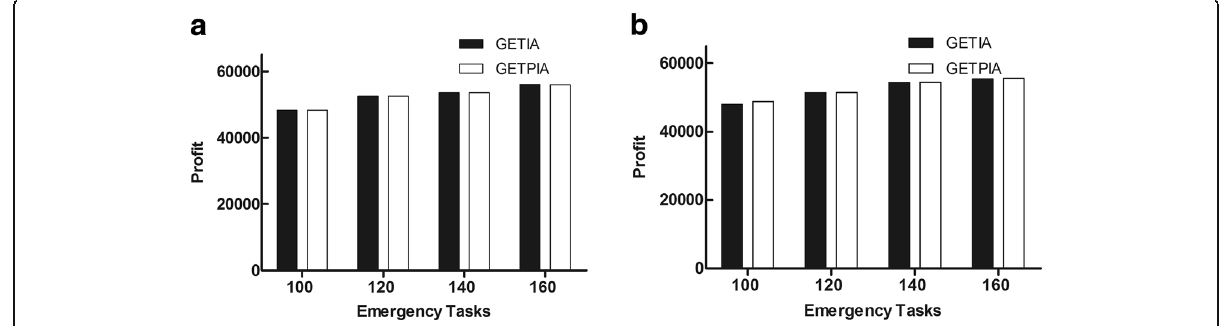
Fig. 9 Revenue comparison under 300 original tasks ( a , b